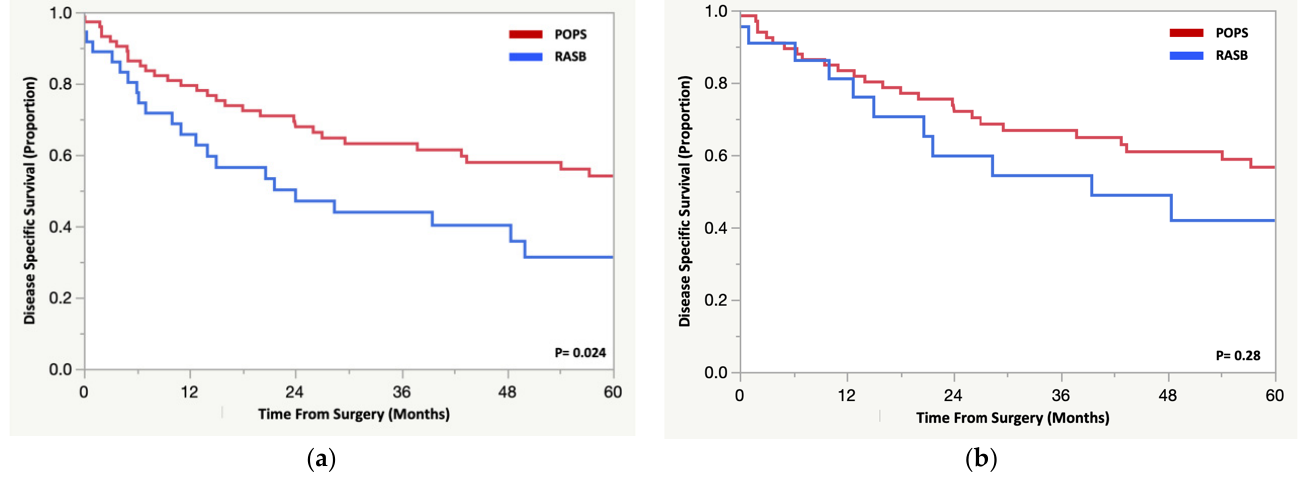
Figure 2. Kaplan Meier analysis for overall disease specific survival between ( a ) patients with a radiation-associated sarcoma of the pelvis/sacrum and a primary osteosarcoma or spindle cell sarcoma. Kaplan Meier analysis for disease specific survival ( b ) controlling for the addition of chemotherapy between patients with a radiation-associated sarcoma of the pelvis/sacrum and a primary osteosarcoma or spindle cell sarcoma.